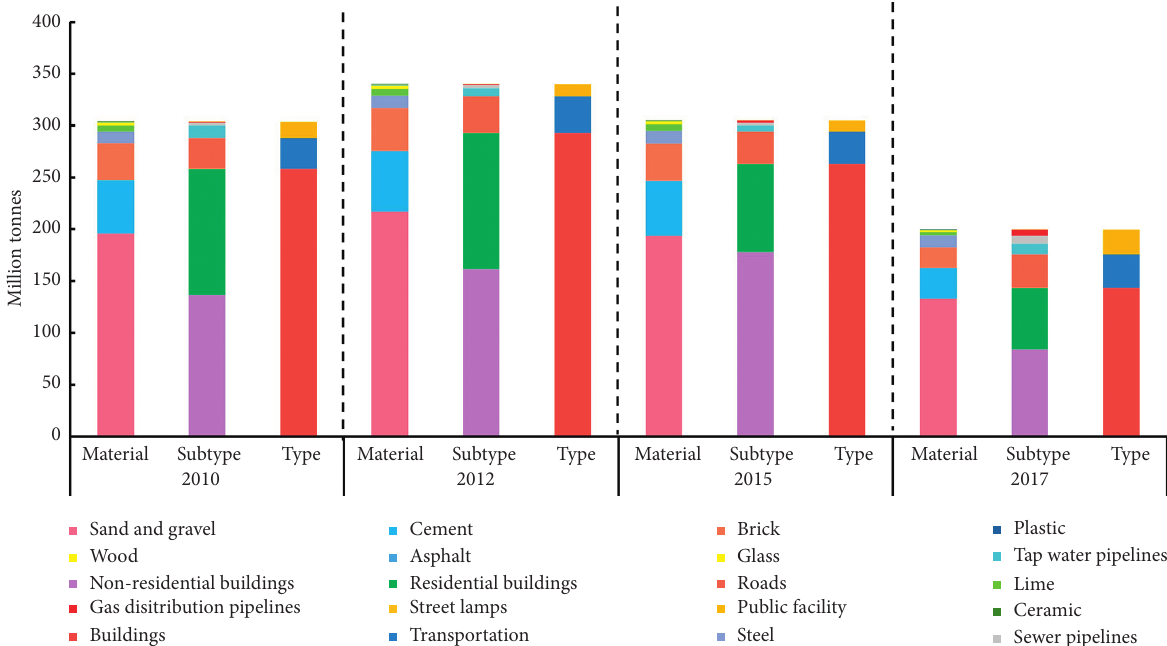
Figure 3: The distribution of material consumption structure across infrastructure types in 34 cities in Northeast China in 2010, 2012, 2015, and 2017.